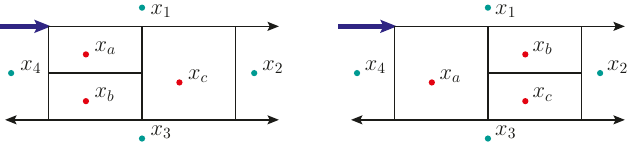
Figure 11. Master graphs for three-loop tr( φ 2 ) form